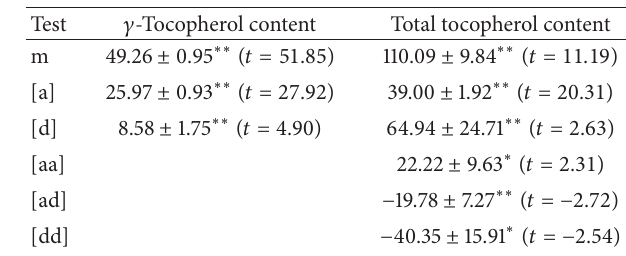
Table 3: Estimates of additive, dominance, and digenic interaction parameters ( ± standard error) for 𝛾 -tocopherol content and total tocopherol content through a joint scaling test in the cross between the Ethiopian mustard lines BCT-6, with reduced 𝛾 -tocopherol content, and C-101, with conventional levels of 𝛾 -tocopherol. 𝑡 - values for significance tests are given in